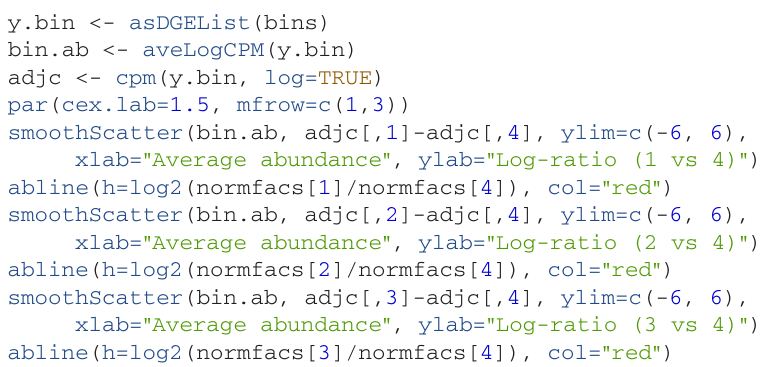
specific background in the neighbouring regions. In this case, a window size of 10 bp is used. win.data <- windowCounts(bam.files, param=param, width=10, ext=frag.len)